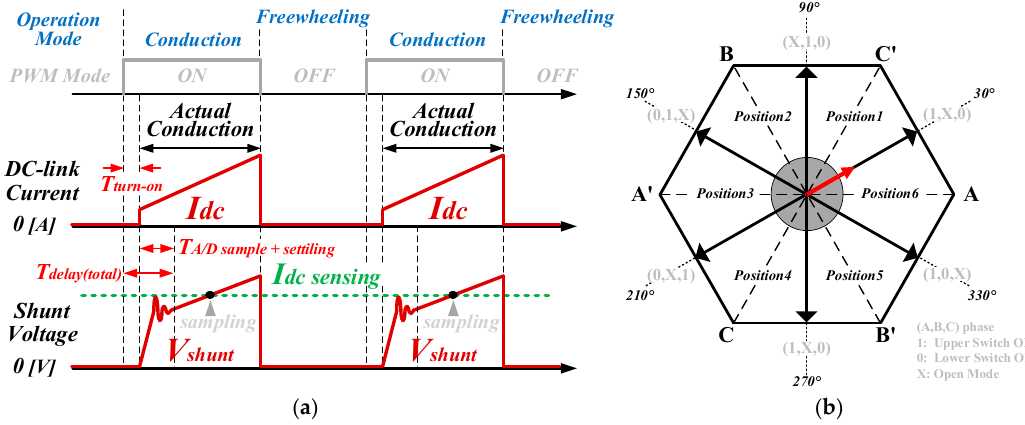
Figure 5. Delay time and unmeasurable region of DC-link current sensing: ( a ) Delay time during shunt voltage sampling; and ( b ) Unmeasurable current region of DC-link single-shunt.